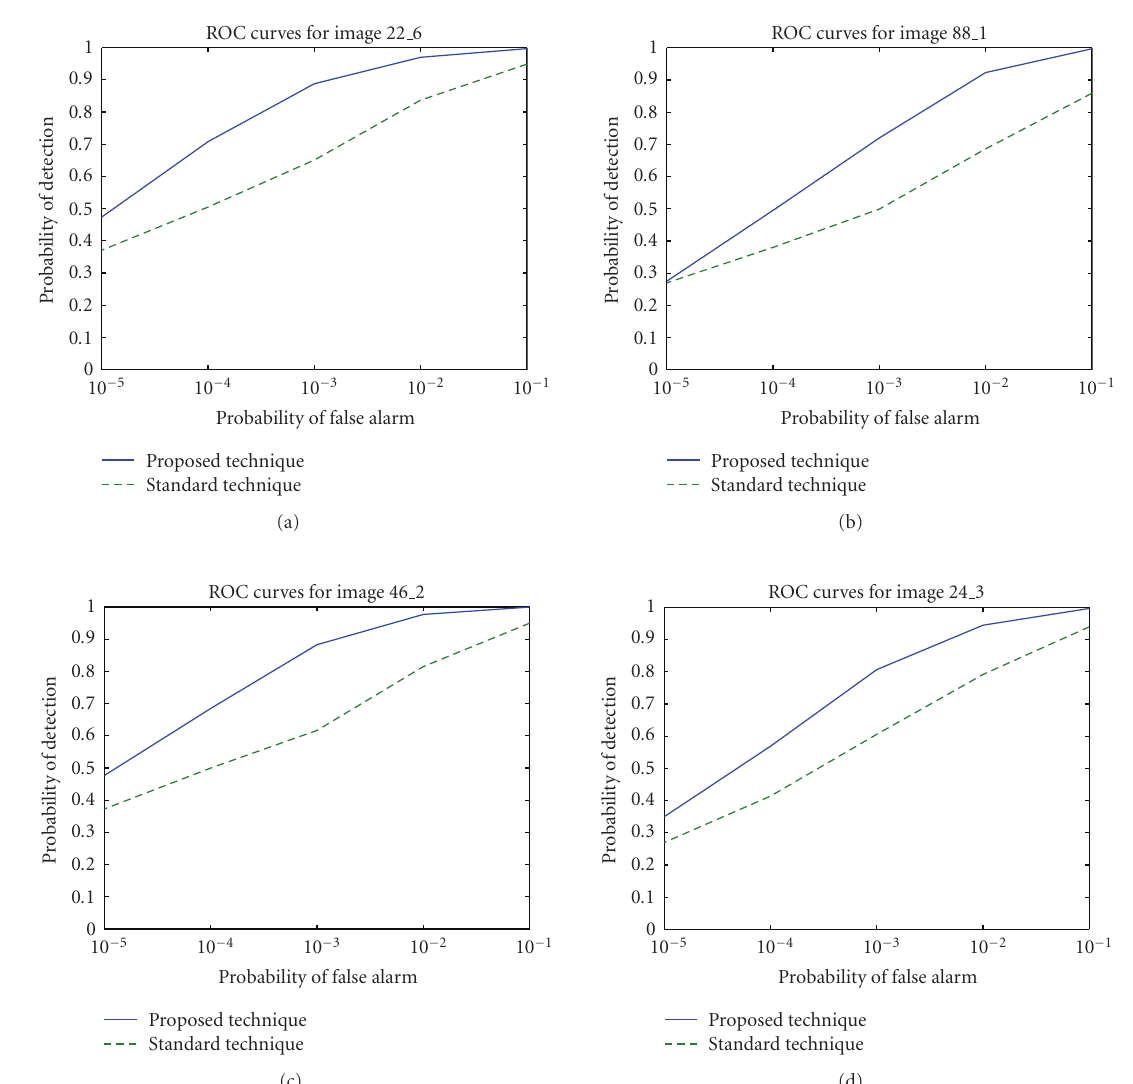
Figure 9: ROC curves of segmented, watermarked images. Watermarking applied in the DWT domain. Strength λ = 0 .